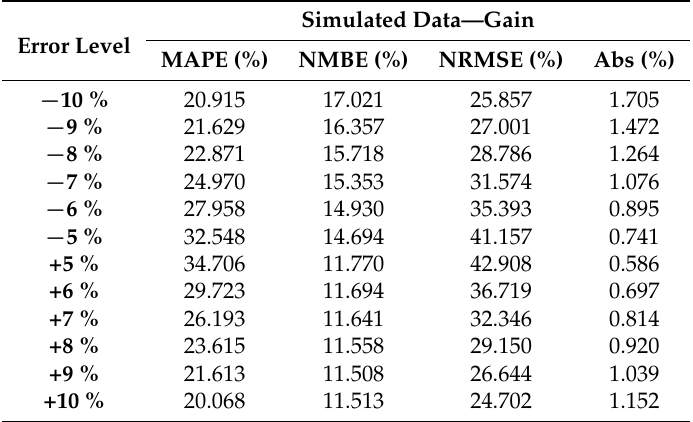
Table 1. Error indicators for different gain error levels—Simulated data.